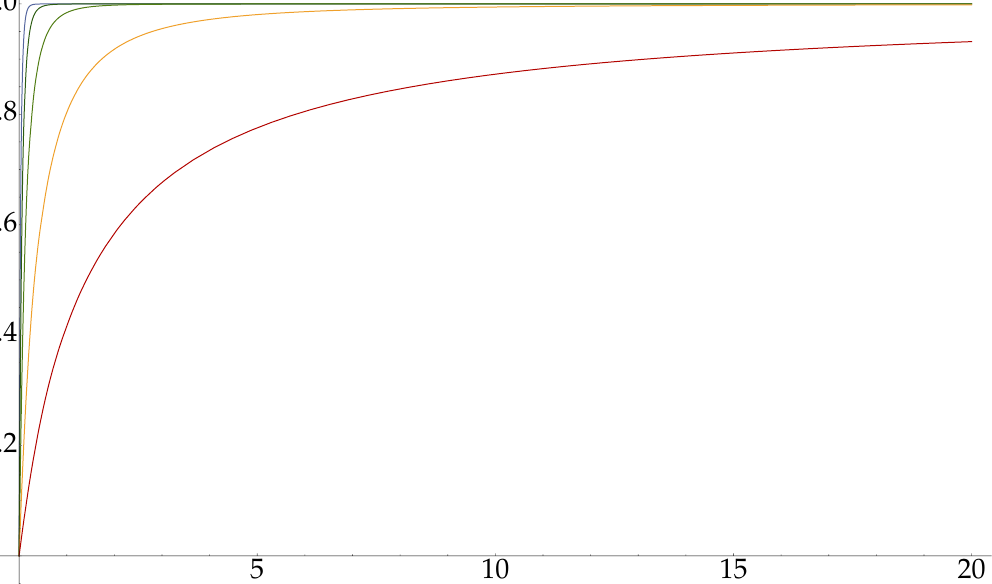
Figure 3 . Plot of the solution, (3.43), in the extremal limit, for d = 4 ; 5 ; 7 ; 10 ; 14 (with Q 1 = Q 2 = 1 and (cid:11)(cid:30) 1 = 1). For these parameters, (cid:30) 0 = 0. We have shifted the radial coordinate so that the horizon is at r =